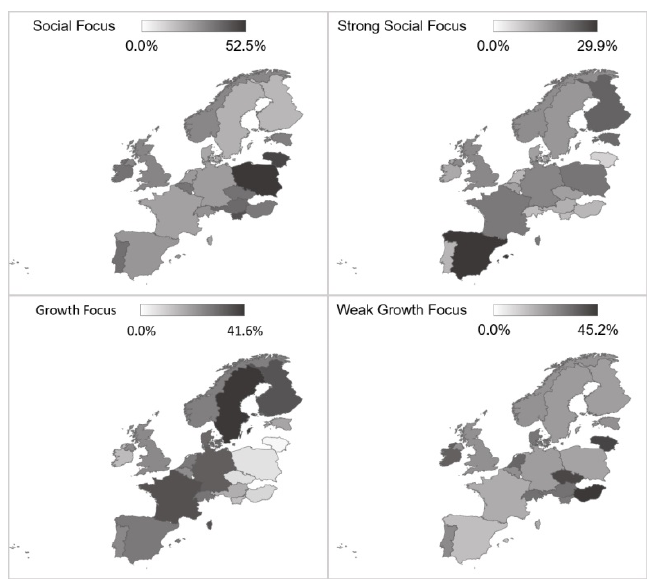
Figure 5. Clusters incidence by geographical distribution.